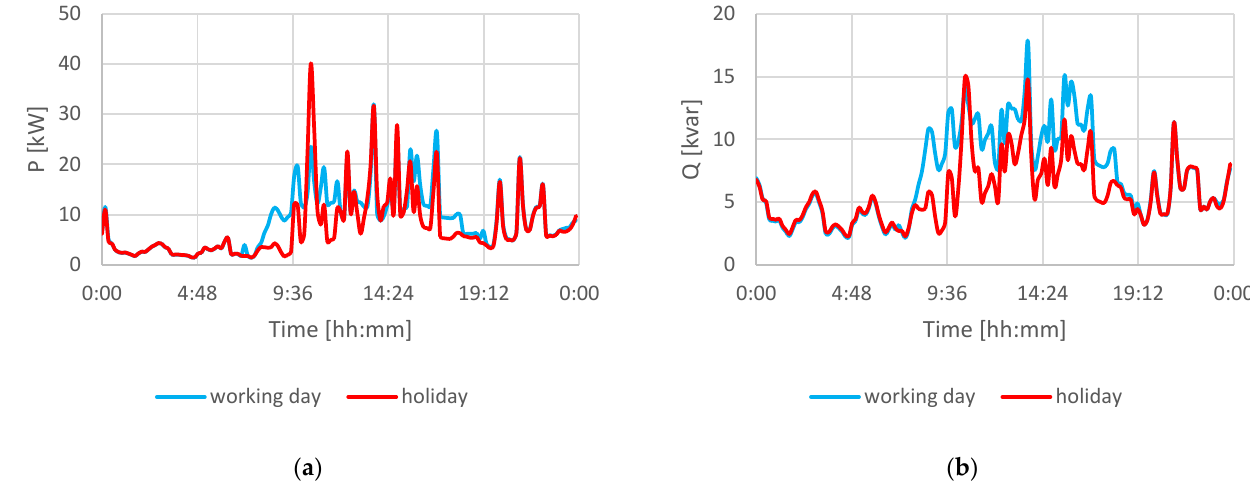
Figure 5. ( a ) Total daily active power demand characteristics of the test microgrid; ( b ) Total daily reactive power demand characteristics of the test microgrid.